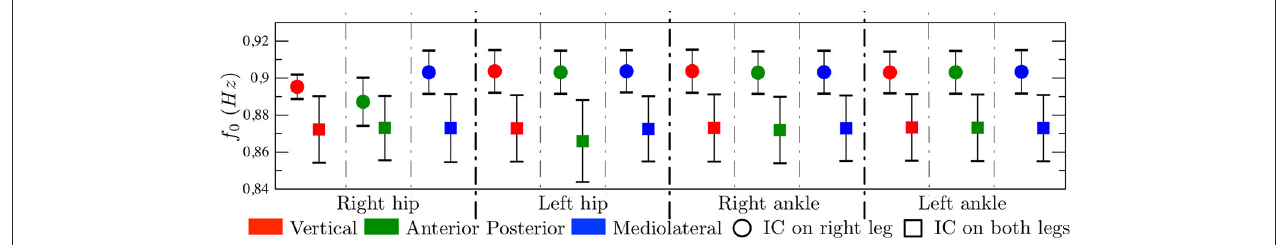
FIGURE 6 | Fundamental frequency represented as mean ± std. Comparison between PAD patients with IC on right leg and with IC on both legs. Quantitative results but not hypothesis